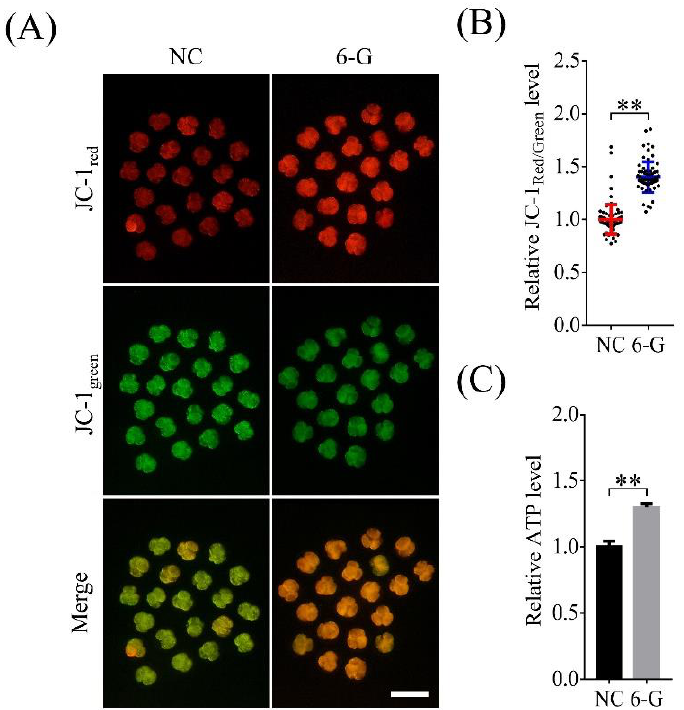
Figure 5. Effects of 6-gingerol (6-G) on mitochondrial function in 4-cell-stage embryos. ( A ) Repre- sentative images of 5,5′,6,6′-tetrachloro-1,1′,3,3′-tetraethylbenzimidazolylcarbocyanine-iodide dye (JC-1) in the NC and 6-G treatment groups. Bar = 200 μm. ( B ) Relative JC-1 Red/Green fluorescence in- tensity ratios with or without 6-G treatment. R = 4. ( C ) Relative ATP level change in 4-cell-stage embryos after 6-G treatment. R = 3. ** p < 0.01.